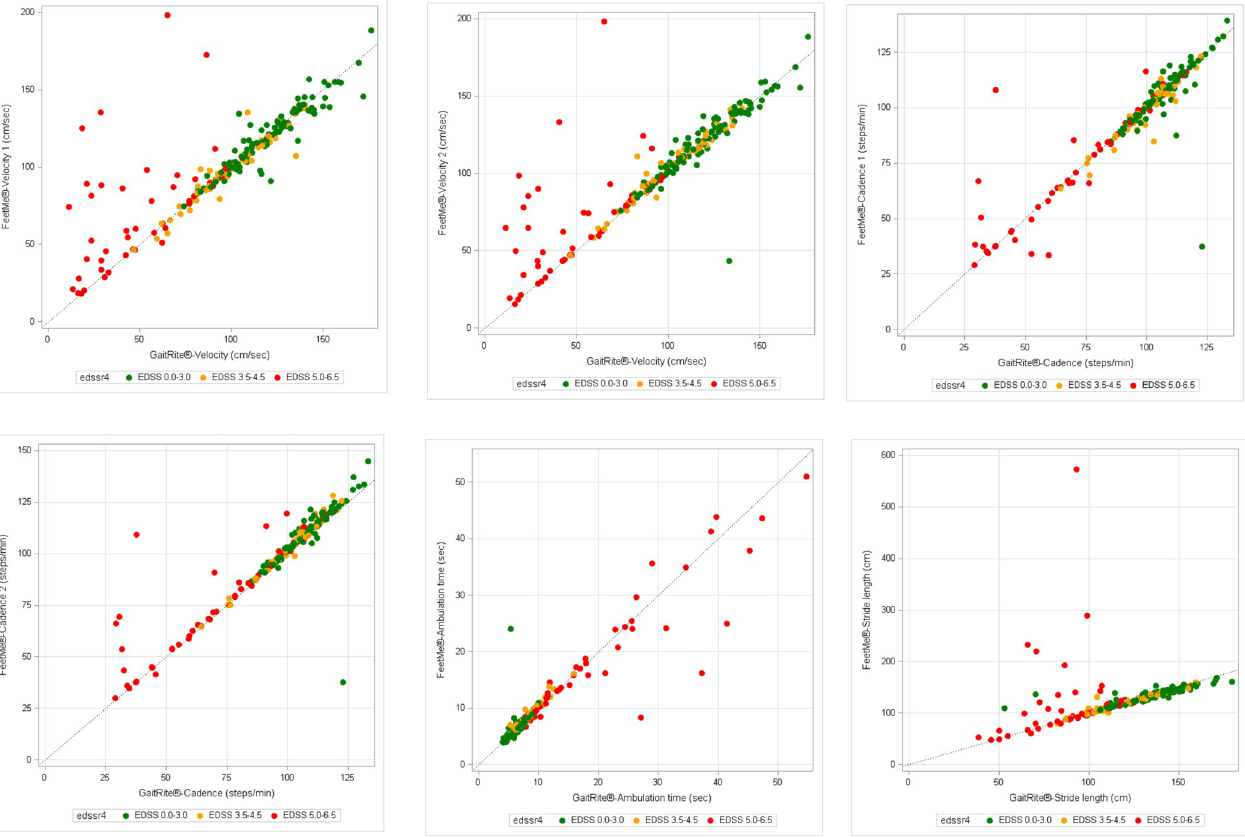
Fig 3. Scatter plots for gait parameters obtained by GAITRite 1 and FeetMe 1 Monitor devices in 25SG population. (A) Velocity 1 (cm/sec) (B) Velocity 2 cm/sec (C) Cadence 1 (steps/min) (D) Cadence 2 (steps/min) (E) Ambulation time (sec) (F) Stride length (cm). EDSS = Expanded Disability Status Scale; x = y is the line of equality between GAITRite 1 and FeetMe 1